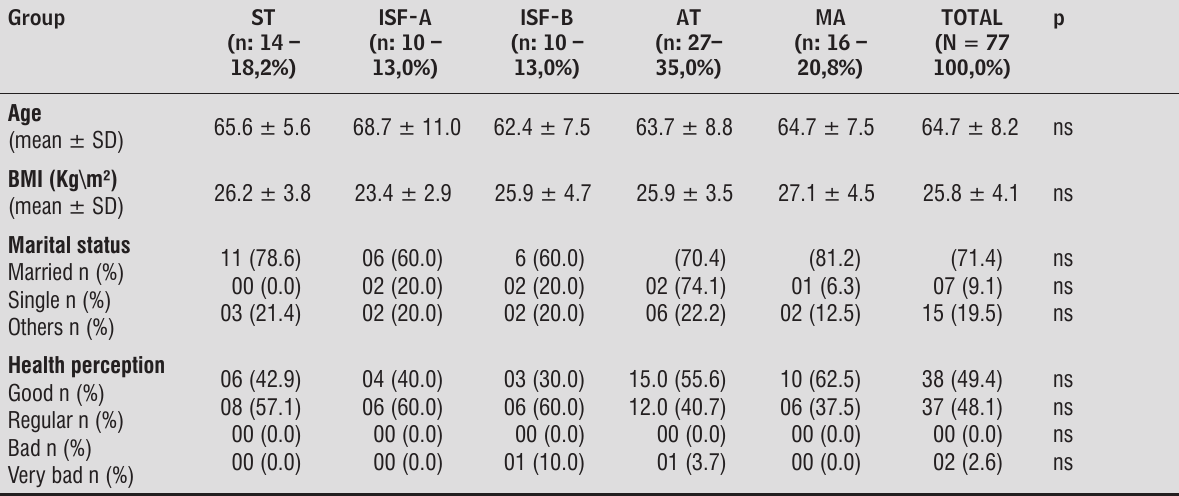
Table 1 – Demographic variables and classification of the usual practice of physical activity of elderly people Group ST